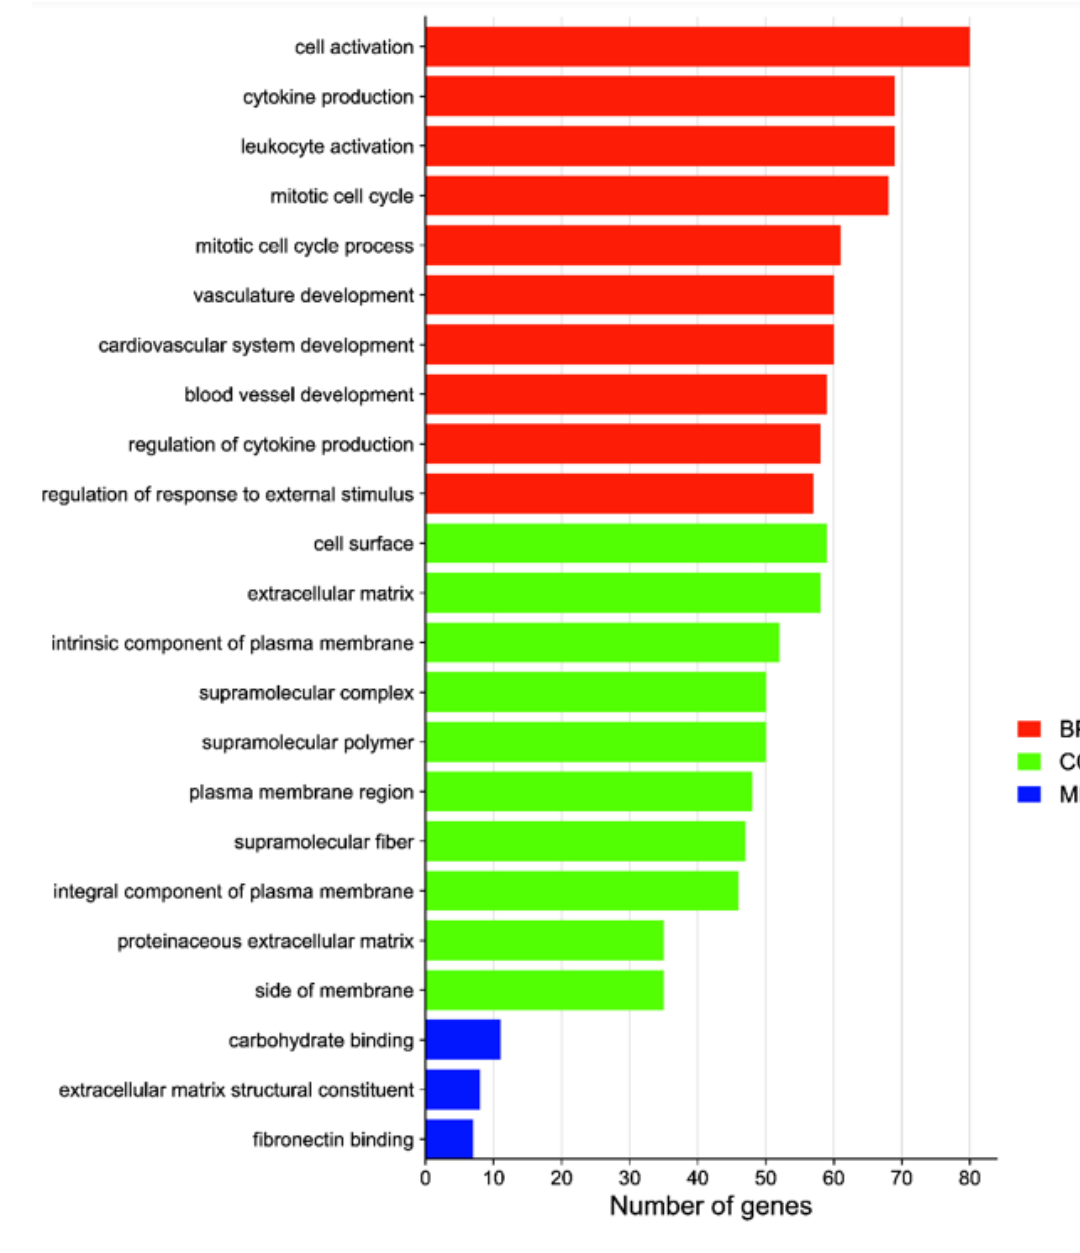
Figure 3. GO enrichment analysis of DEGs between the treatment and control groups. The vertical coordinate indicates the enriched GO term, and the horizontal coordinate indicates the number of DEGs in that term. Abbreviations: biological processes (BP), cellular components (CC), molecular functions (MF).